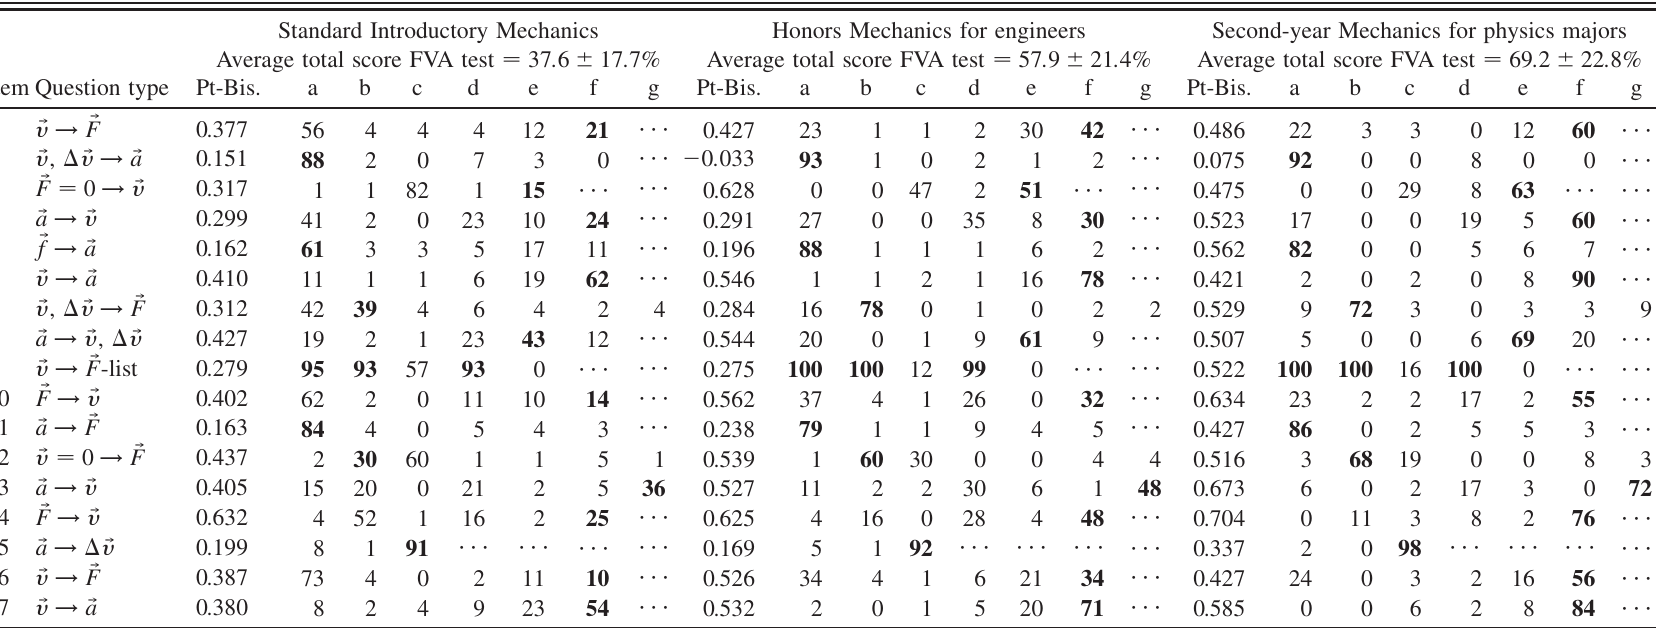
TABLE VI. Summary of individual FVA test item statistics for three course levels. Reported are the response percentages for each available response on all 17 items. Correct responses choices are in bold. (Note that question 9 required students to ‘‘circle all that apply.’’ Thus, response percentages reflect the percentage of students circling that response. The correct response was circling a, b, and d.) Pt-Bis. is point biserial